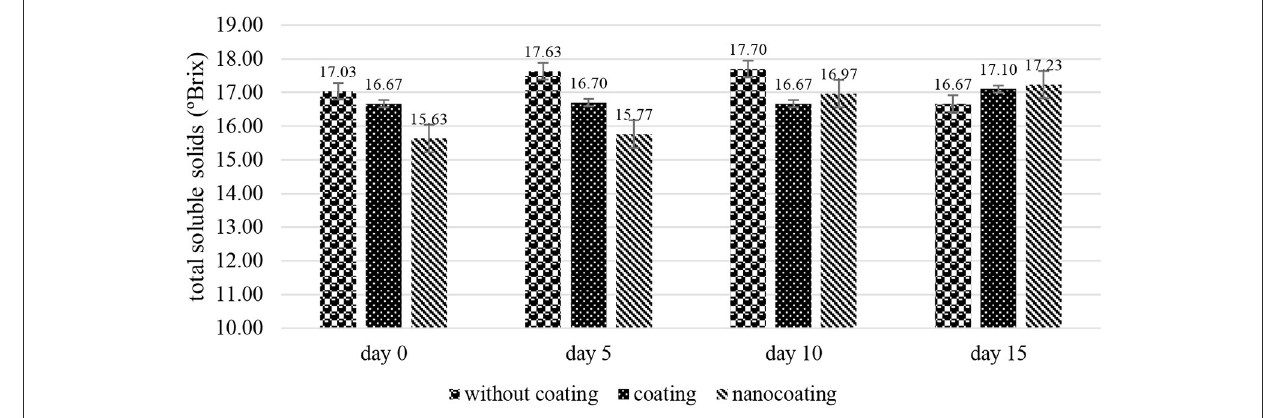
FIGURE5 Total soluble solids ( ◦ Brix) of Siamese orange.